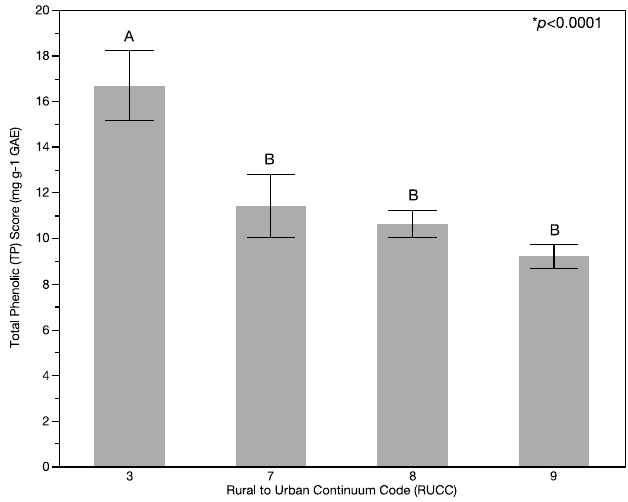
Figure 1. Variation of combined fruit and vegetable (FV) quality based on FV total phenolic (TP) scores with rurality. FV quality as determined by FV total phenolic (TP) scores is lower in more rural areas (higher rural urban continuum codes (RUCC) represent more rural areas). RUCC codes that have the same letter (A or B) above the standard error bar in the graph show no statistical difference while RUCC codes that have different letters above the bar in the graph are statistically different. Each error bar is constructed using one standard error from the mean.